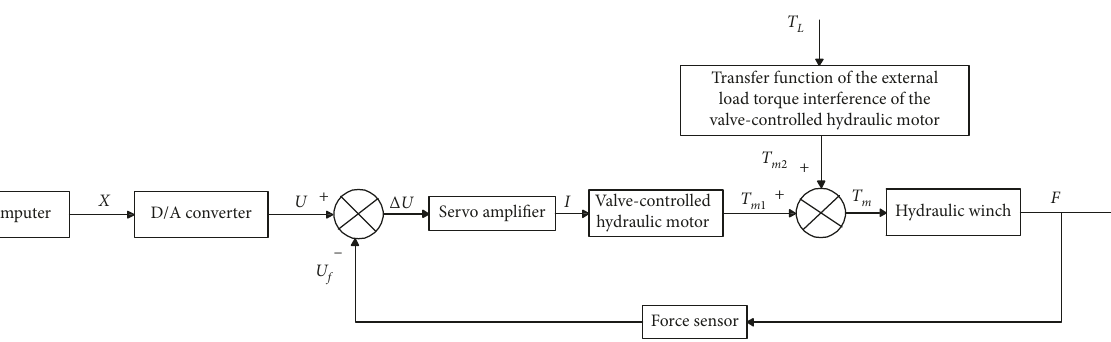
Figure 1: The working process of the wave compensation system [13].